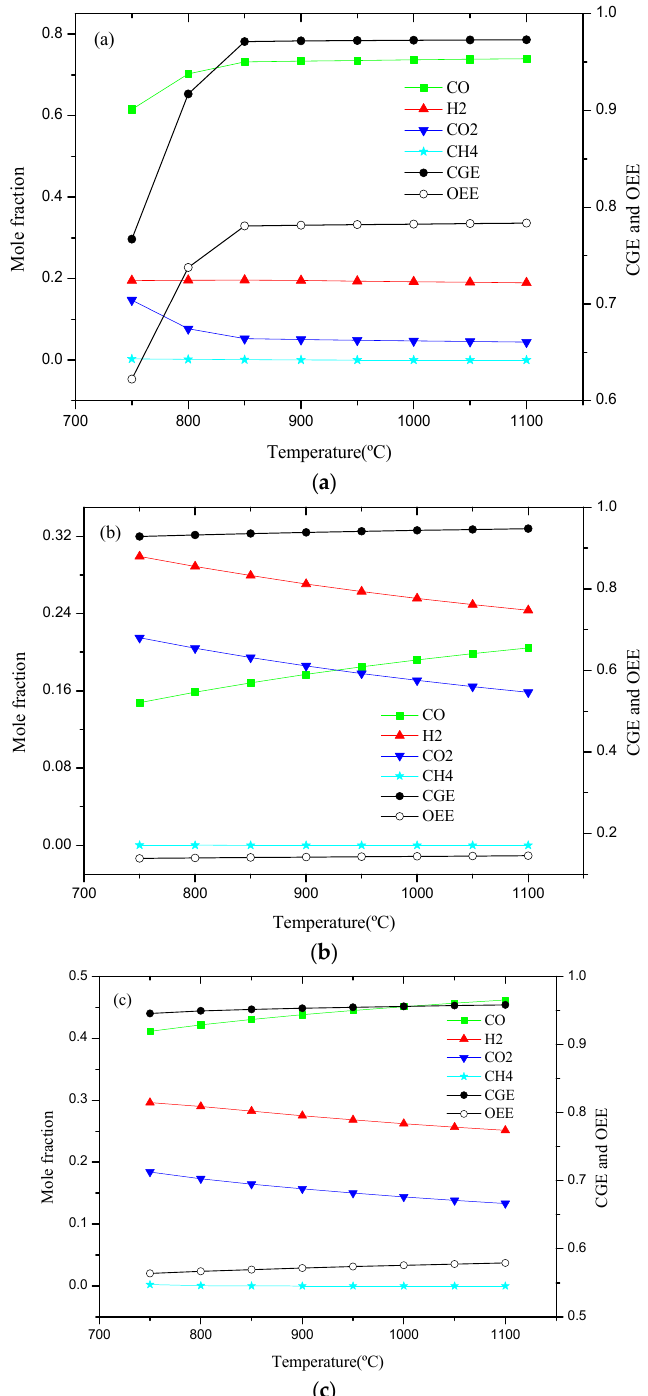
Figure 3. Effect of gasification temperature T on raw syngas composition and system performance ( R o = 0.2 and R c = 0.5). ( a ) BC; ( b ) MSW; ( c ) R M = 0.6